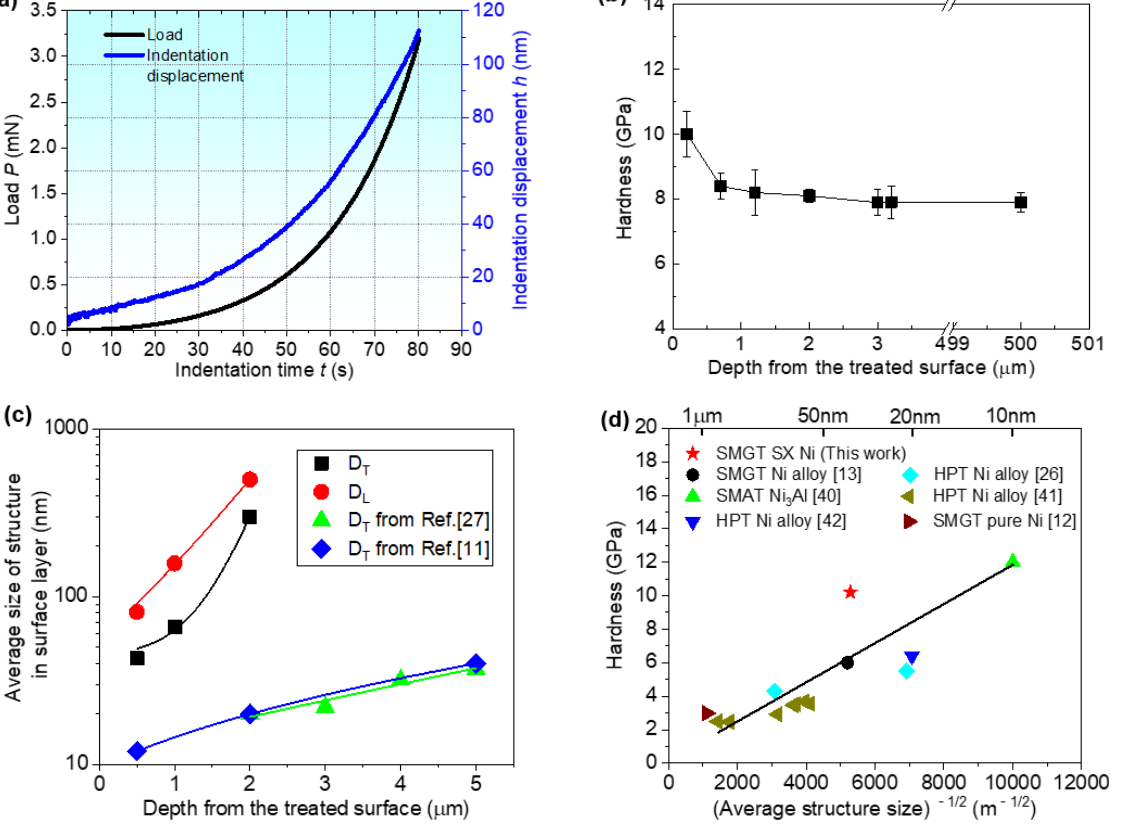
Figure 9. ( a ) Typical curves of load and displacement with time, and variations of ( b ) hardness and ( c ) structure size along depth from the treated surface, and ( d ) hardness vs. structure size for the SMCGT